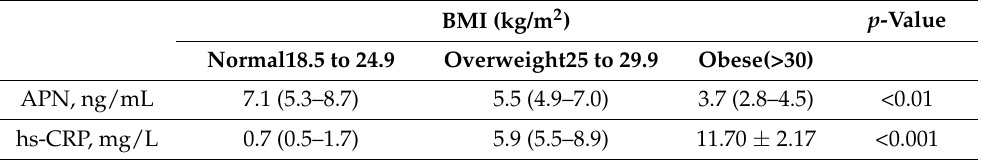
Table 3. Median values of adiponectin (APN) and hs-CRP according to